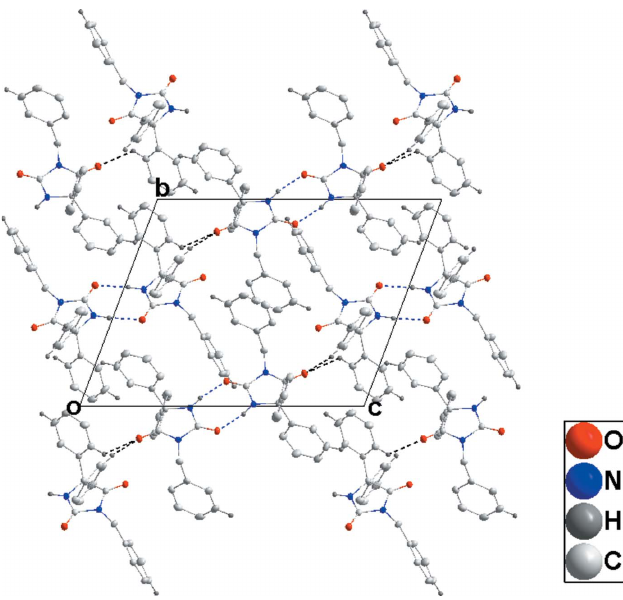
Figure 3 Detail of the C—H (cid:2)(cid:2)(cid:2) O hydrogen bonding holding the sheets together viewed along the a -axis direction. Color codes are the same as in Fig. 2.